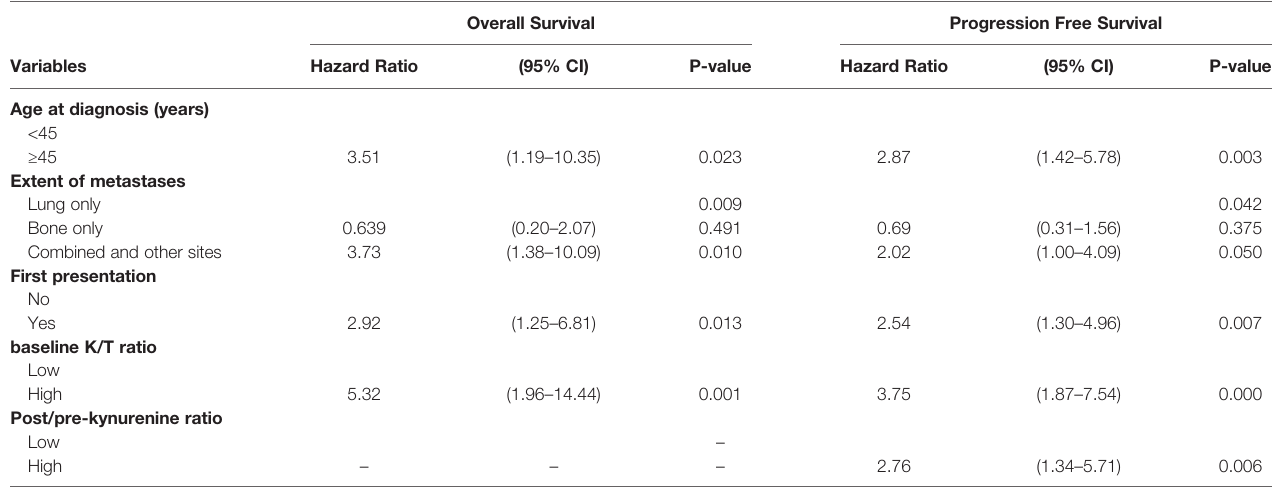
TABLE 2 | Multivariate Analyses of Factors Predicting Overall Survival and Progression Free Survival.